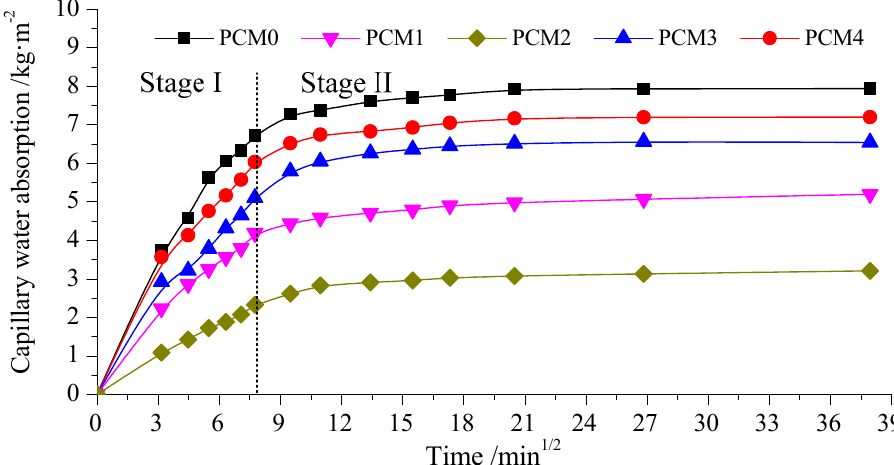
Figure 8. Capillary water absorption of cement mortar with di ff erent PVA contents (0~24 h).